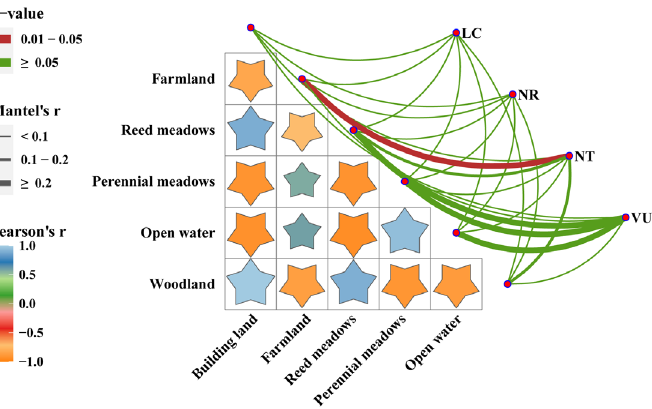
Figure 9. Correlation between threat categories and habitat types by Mantel test. Pearson’s r rep- resents the correlation coefficients among different habitat types; Mantel’s r reveals the correlation coefficients between ecotypes and habitat types, and the thicker the line is, the larger the correla- tion coefficients are; p -value represents the significance of the correlation between ecotypes and habitat